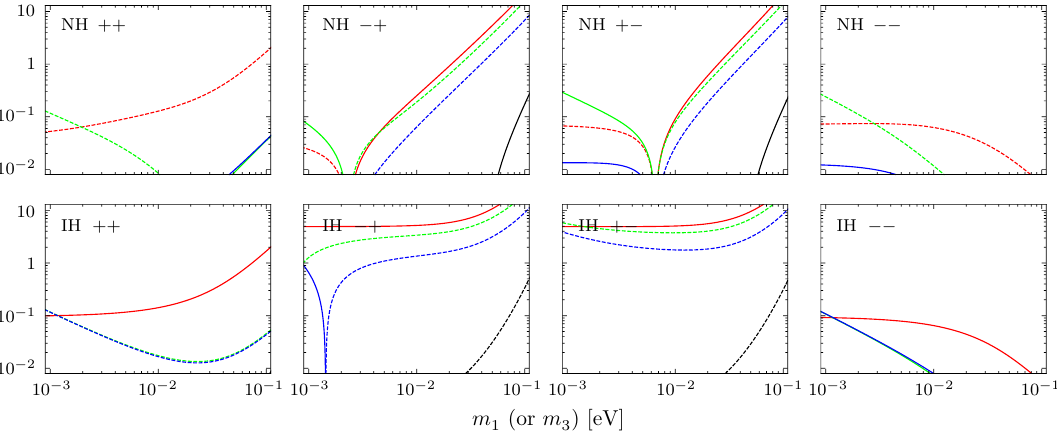
Figure 1 . The mixing-parameter deviations induced by R green and (cid:1) (cid:27) in blue) against the lightest neutrino mass m various combinations of (cid:26) (0) and (cid:27) (0) with (cid:14) (0) = (cid:0) (cid:25)= 2. The signs ++ ; (cid:0) + ; + (cid:0) and (cid:0)(cid:0) respectively stand for [ (cid:26) (0) ; (cid:27) (0) ] = [0 ; 0] ; [ (cid:25)= 2 ; 0] ; [0 ; (cid:25)= 2] and [ (cid:25)= 2 ; (cid:25)= 2].